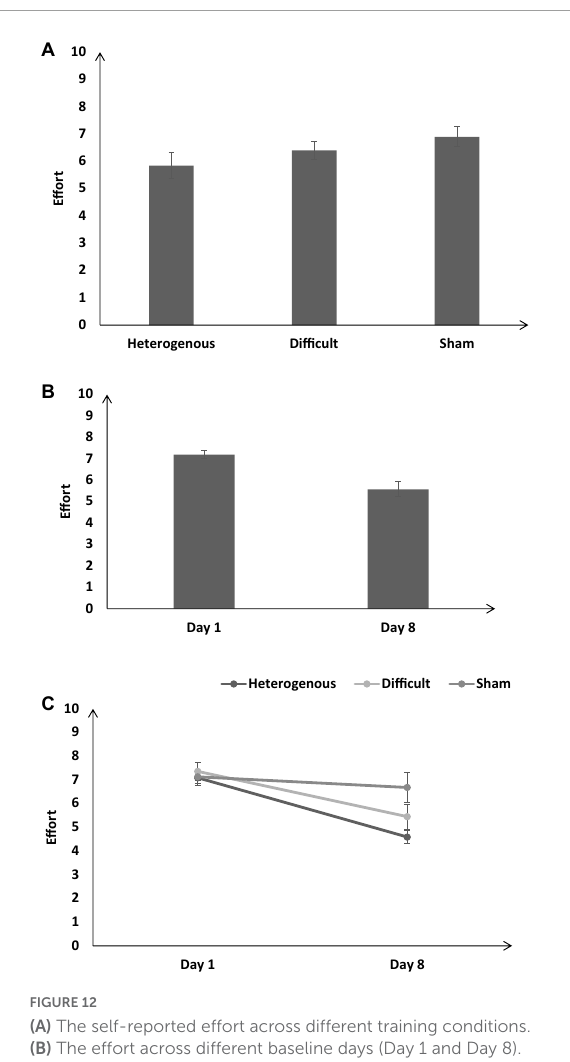
FIGURE12 (A) The self-reported effort across different training conditions. (B) The effort across different baseline days (Day 1 and Day 8). (C) The effort across different training conditions and baseline days (Day 1 and Day 8). The error bars show 95% CI around point